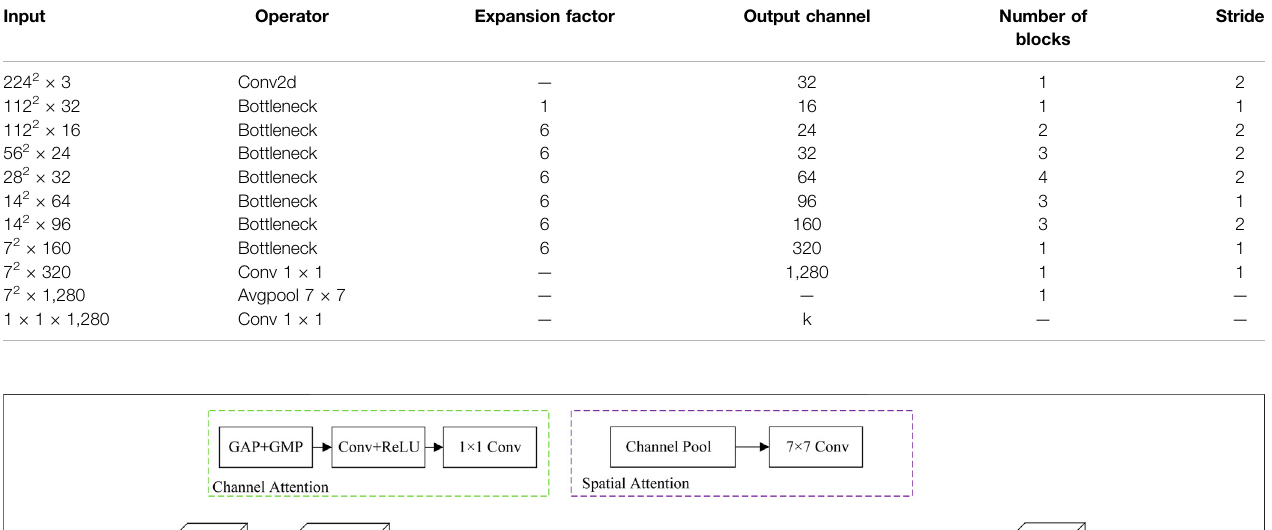
TABLE 1 | The network structure of MobileNetV2.